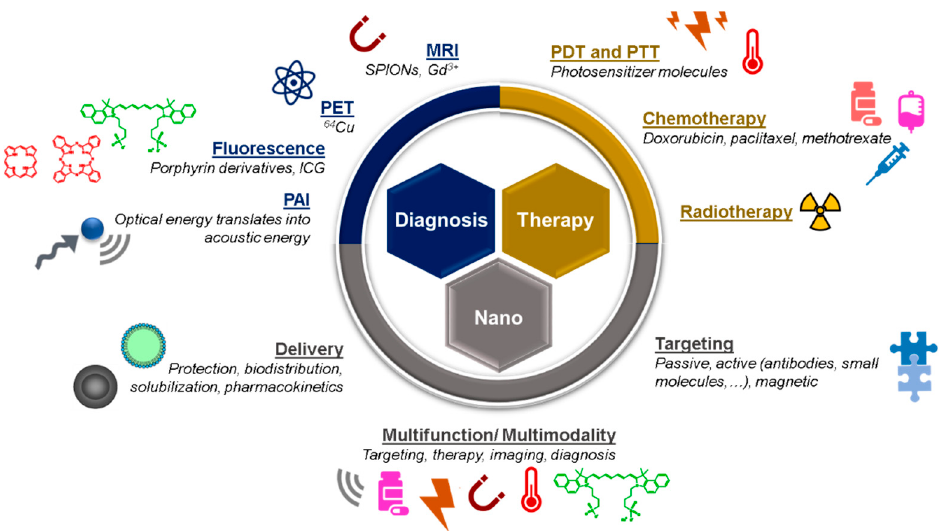
Figure 2. Schematic illustration of triple features in theranostic nanoplatforms, namely nano-sized particle, therapeutic, and diagnostic agents. Adapted with permission from Zhang P, Hu C, Ran W,